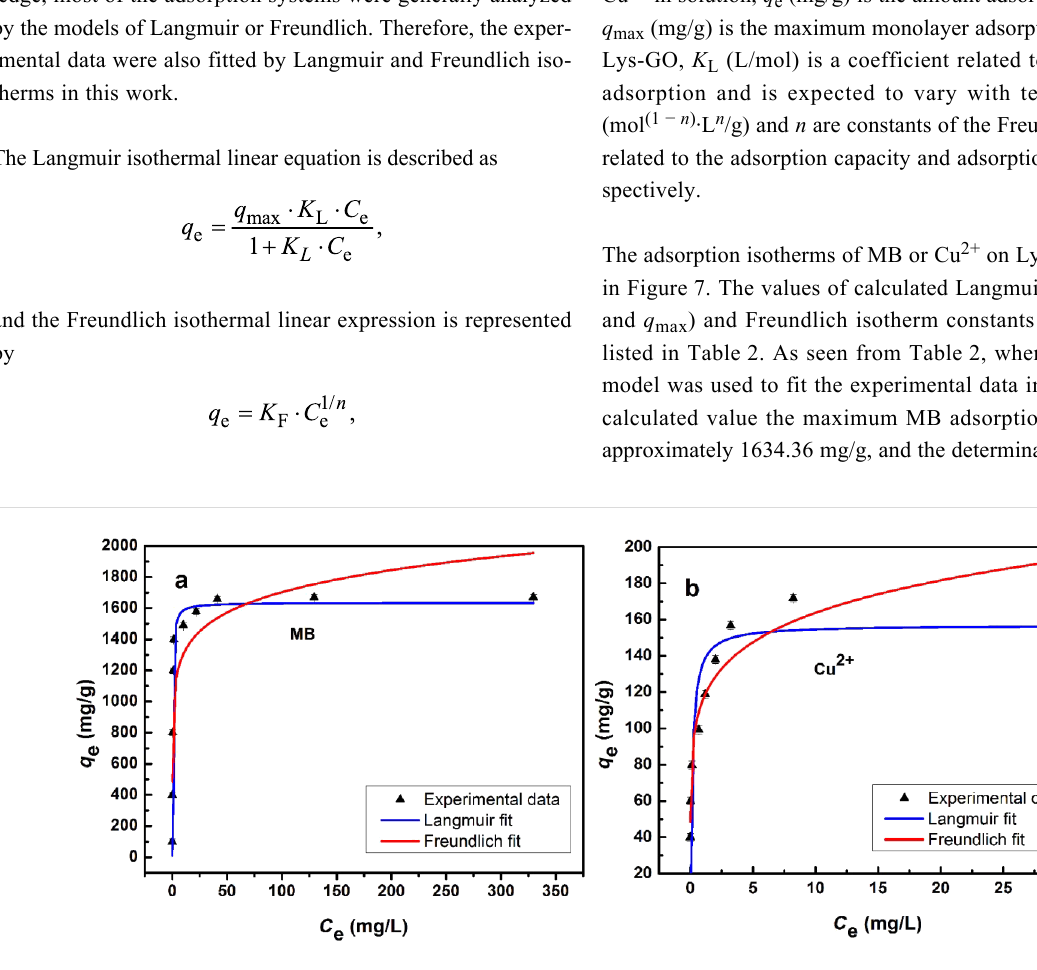
adsorption of molecules on surfaces. To the best of our know- ledge, most of the adsorption systems were generally analyzed by the models of Langmuir or Freundlich. Therefore, the exper- imental data were also fitted by Langmuir and Freundlich iso- therms in this work. The Langmuir isothermal linear equation is described as